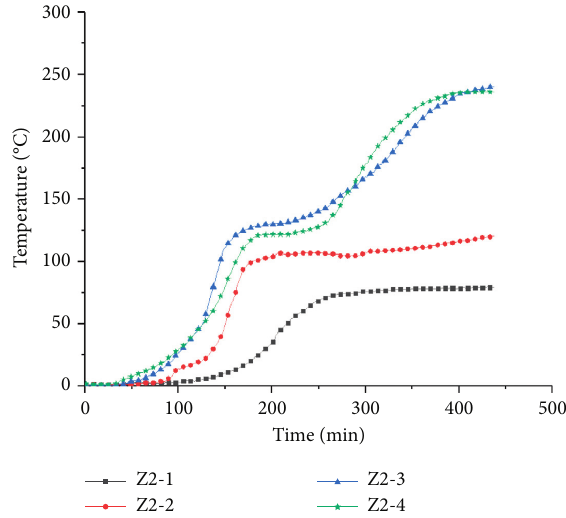
Figure 16: Temperature-time relationships of slab-column